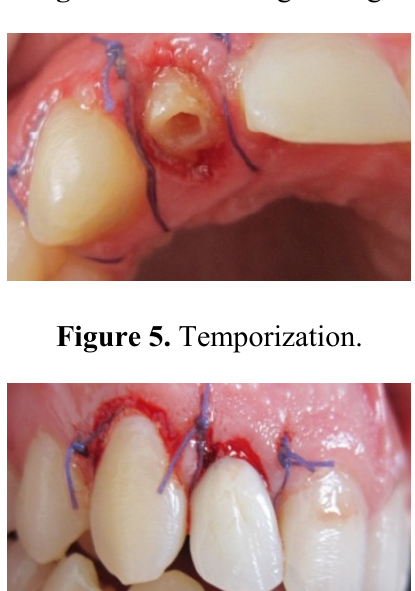
Figure 4. Crown lengthening.